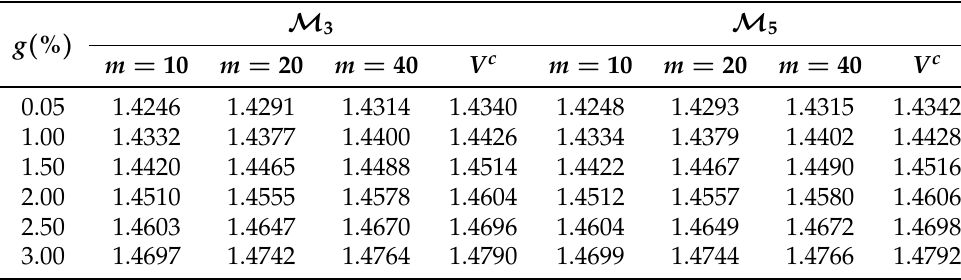
Table A1. Valuation results w.r.t. g , α = 90%, σ = 0.25, and n = 3.